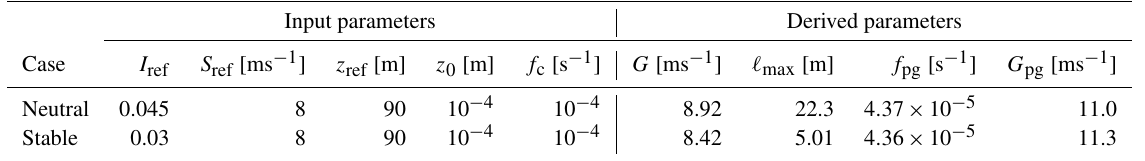
Figure 5. Comparison of k – ε ABL models (with and without wind veer) for stable and neutral conditions offshore using f c (cid:54)= 2 f pg and parameters from Table 1. Bottom plots (e-h) are a magnified view of the top plots (a–d) , focused around a 5MW wind turbine rotor area, which is depicted as black dashed lines. (a, e) Wind speed. (b, f) Wind direction. (c, g) Turbulence intensity. (d, h) Turbulence length scale. Table 1. Summary of input and derived parameters for ABL